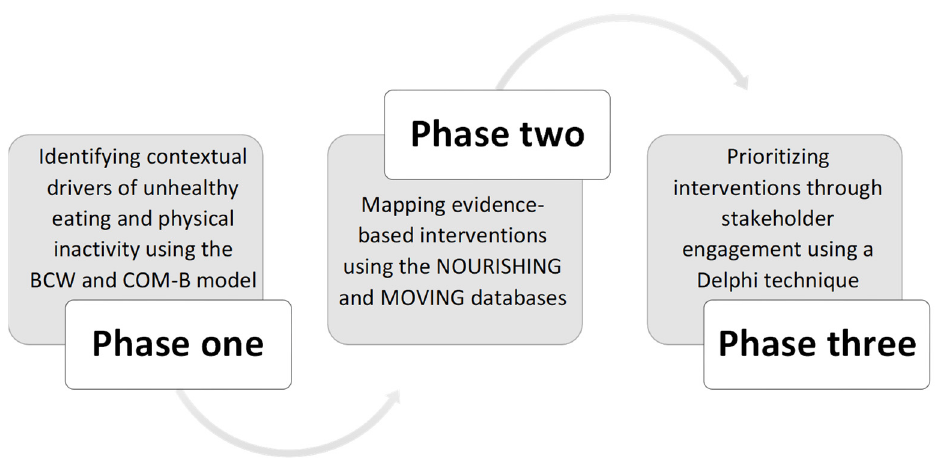
Figure 2. Flowchart outlining the three-phase iterative study design. Table 1. Overview of site-specific data used in secondary analysis of qualitative data.